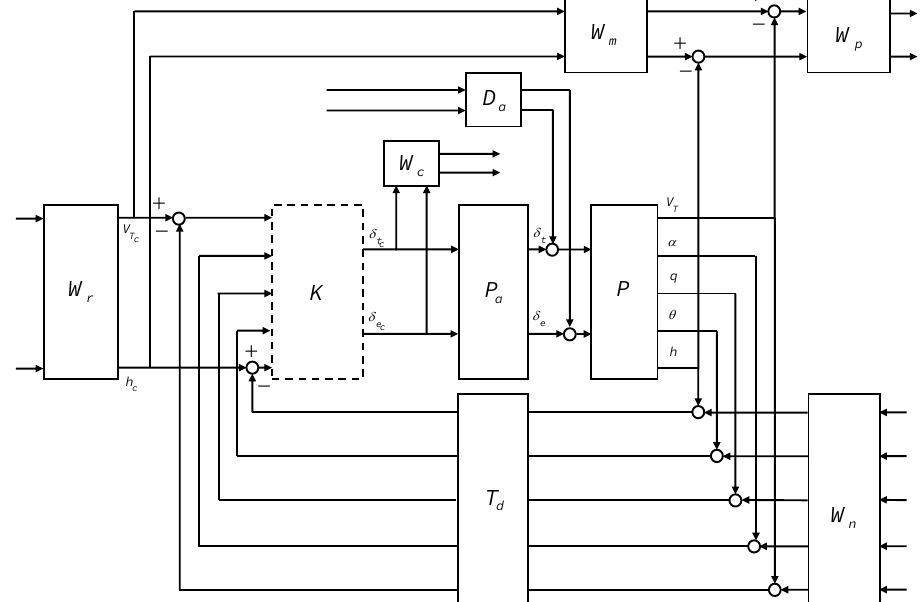
Figure 18. Closed-loop interconnection of the longitudinal autopilot The engine lag was modeled as a second-order system with NMP zero. The reference weight was set to 4 kt for the true airspeed and 10 ft for the altitude. The ideal models for the true airspeed and altitude response to the command were set to have a natural frequency of 2 rad/s and a damping ratio of 0.8 for a gentle response. Performance weights were set to ensure that the model matching error does not exceed two times the measurement noise levels at low frequencies. The sensor measurement error was modeled as white Gaussian noise, and the standard deviation was set to match the sensor specifications of the GTM. In the actuator model, a disturbance of 0.01 deg was added below 0.5 rad/s to account for various